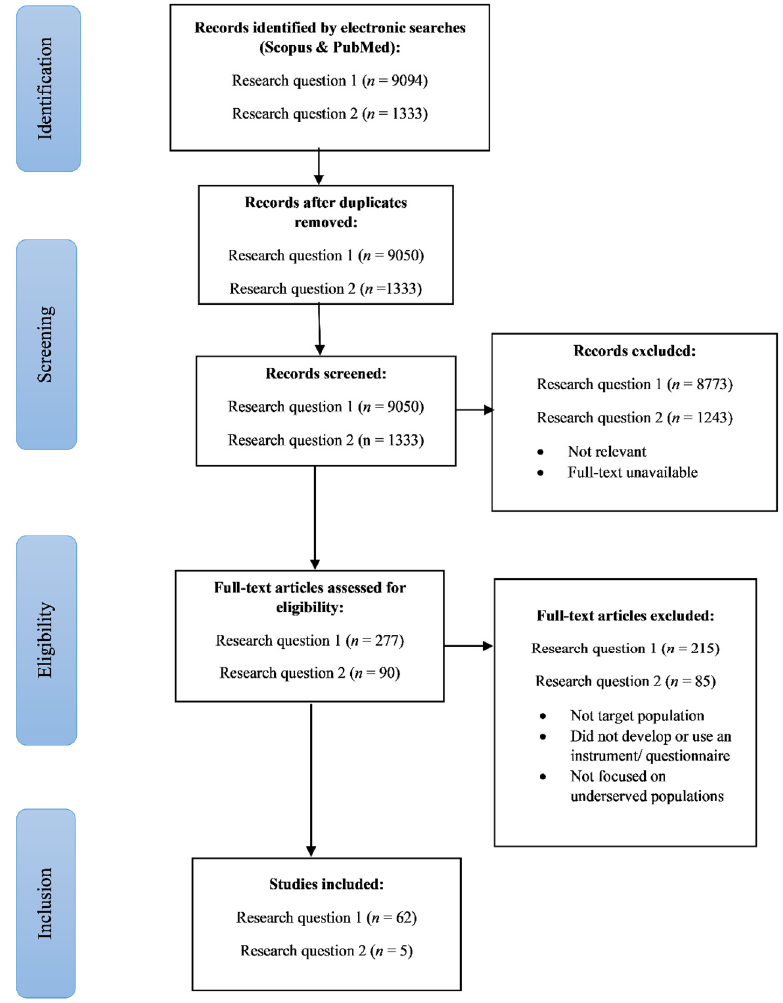
Figure 1. PRISMA flow chart of electronic database search.